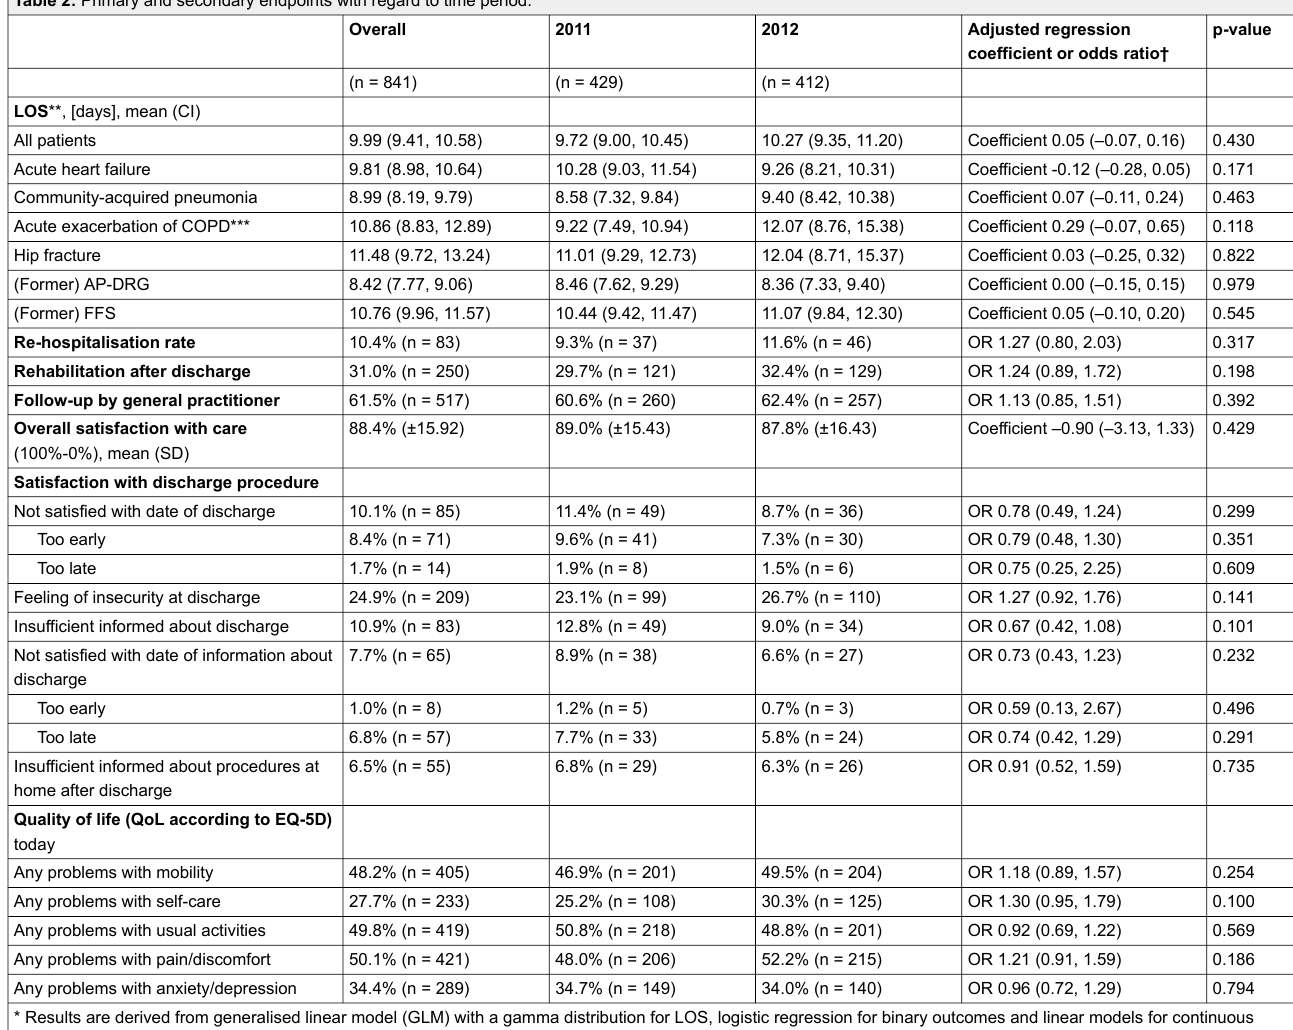
Table 2: Primary and secondary endpoints with regard to time